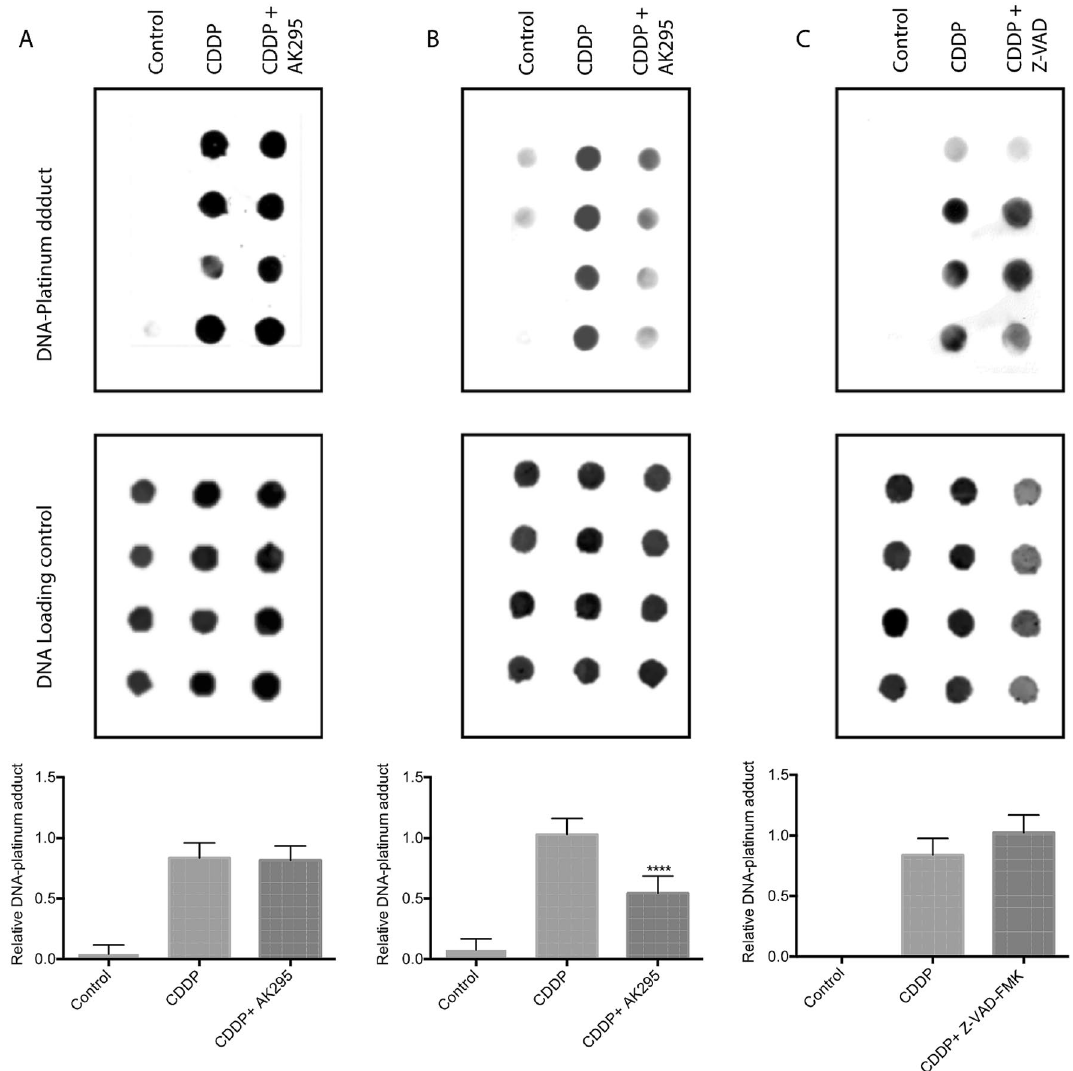
Figure 5. Formation of DNA-platinum adducts by CDDP was not blocked by calpain inhibitor AK-295 in cancer cells ( A ), but it was blocked in neuronal cells ( B ). Caspase inhibition by ZVAD had no effect on DNA- platinum adduct formation in neuronal cells ( C ). Uncropped dot blots show representative blots (n = 4) for each condition and quantitation is shown in graphs below each (n = 8 per group, **** p < 0.001, one-way ANOVA with multiple comparisons, error bars denote